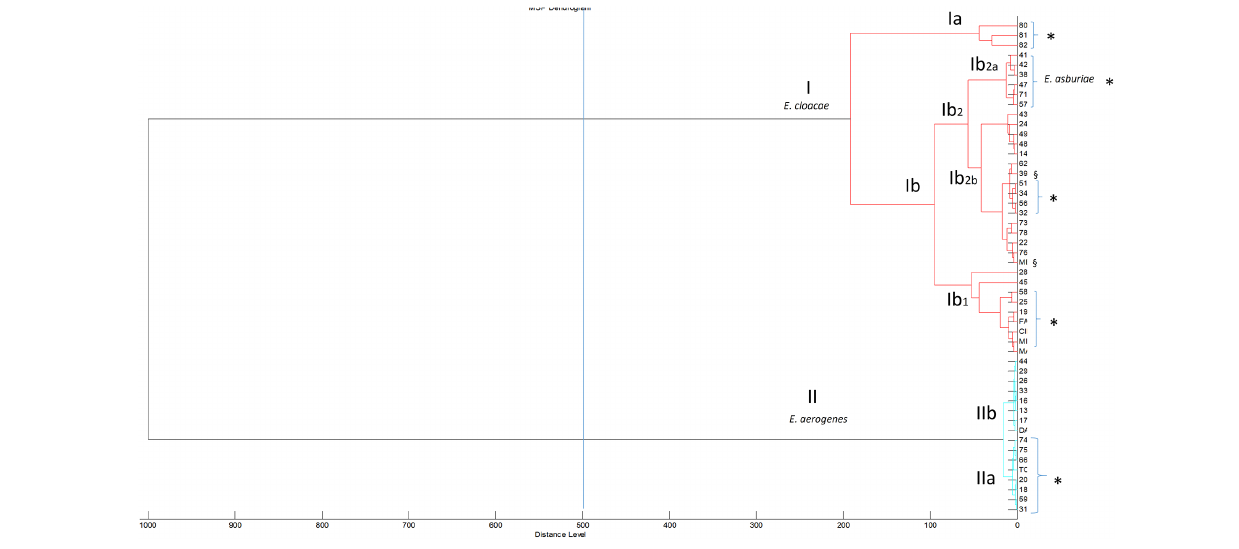
I b2 further includes the sub-clades Ib 2a and Ib 2b . In